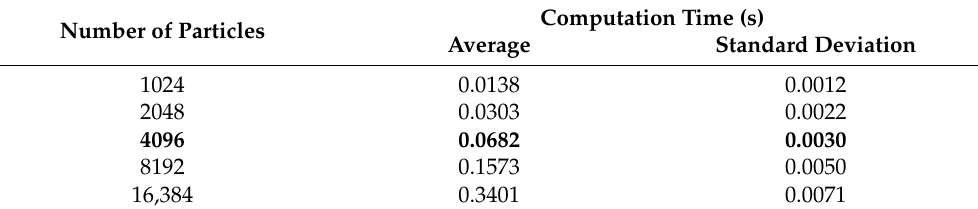
Table 3. Raspberry Pi computing time for several numbers of particles ( ∆ ).